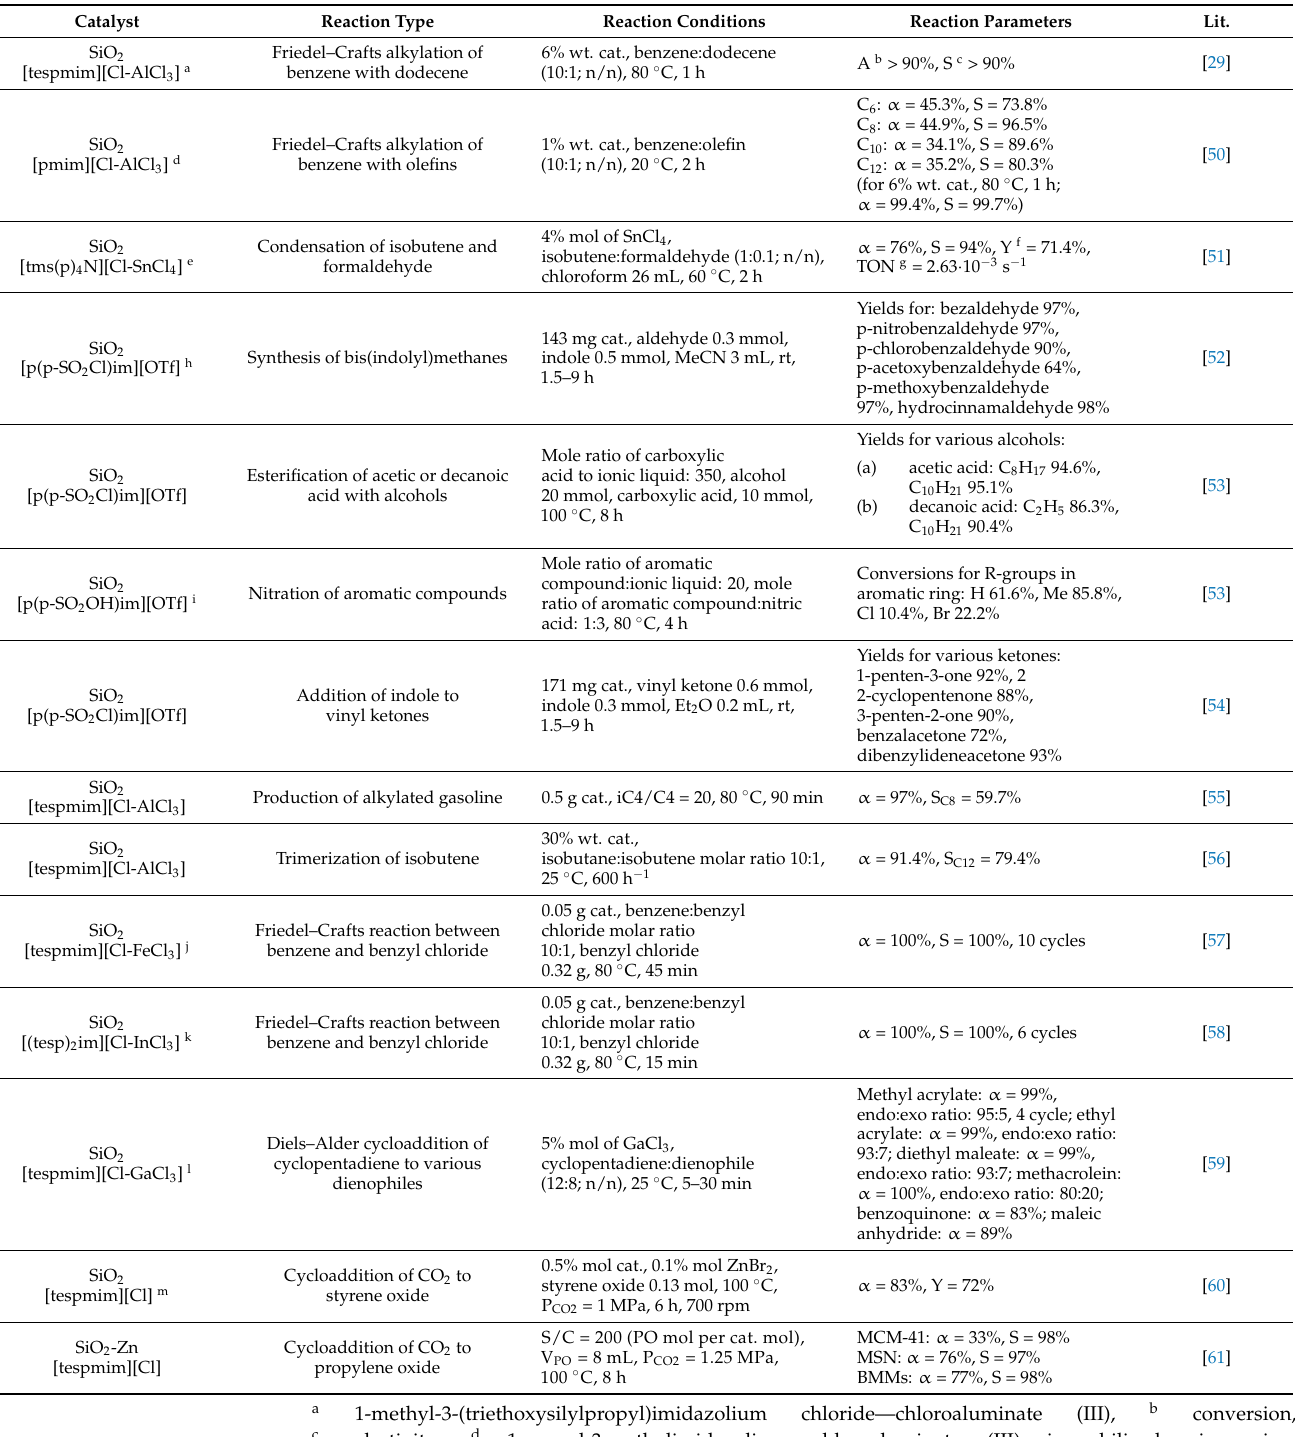
Table 1. Lewis type silica-based SILLP in organic